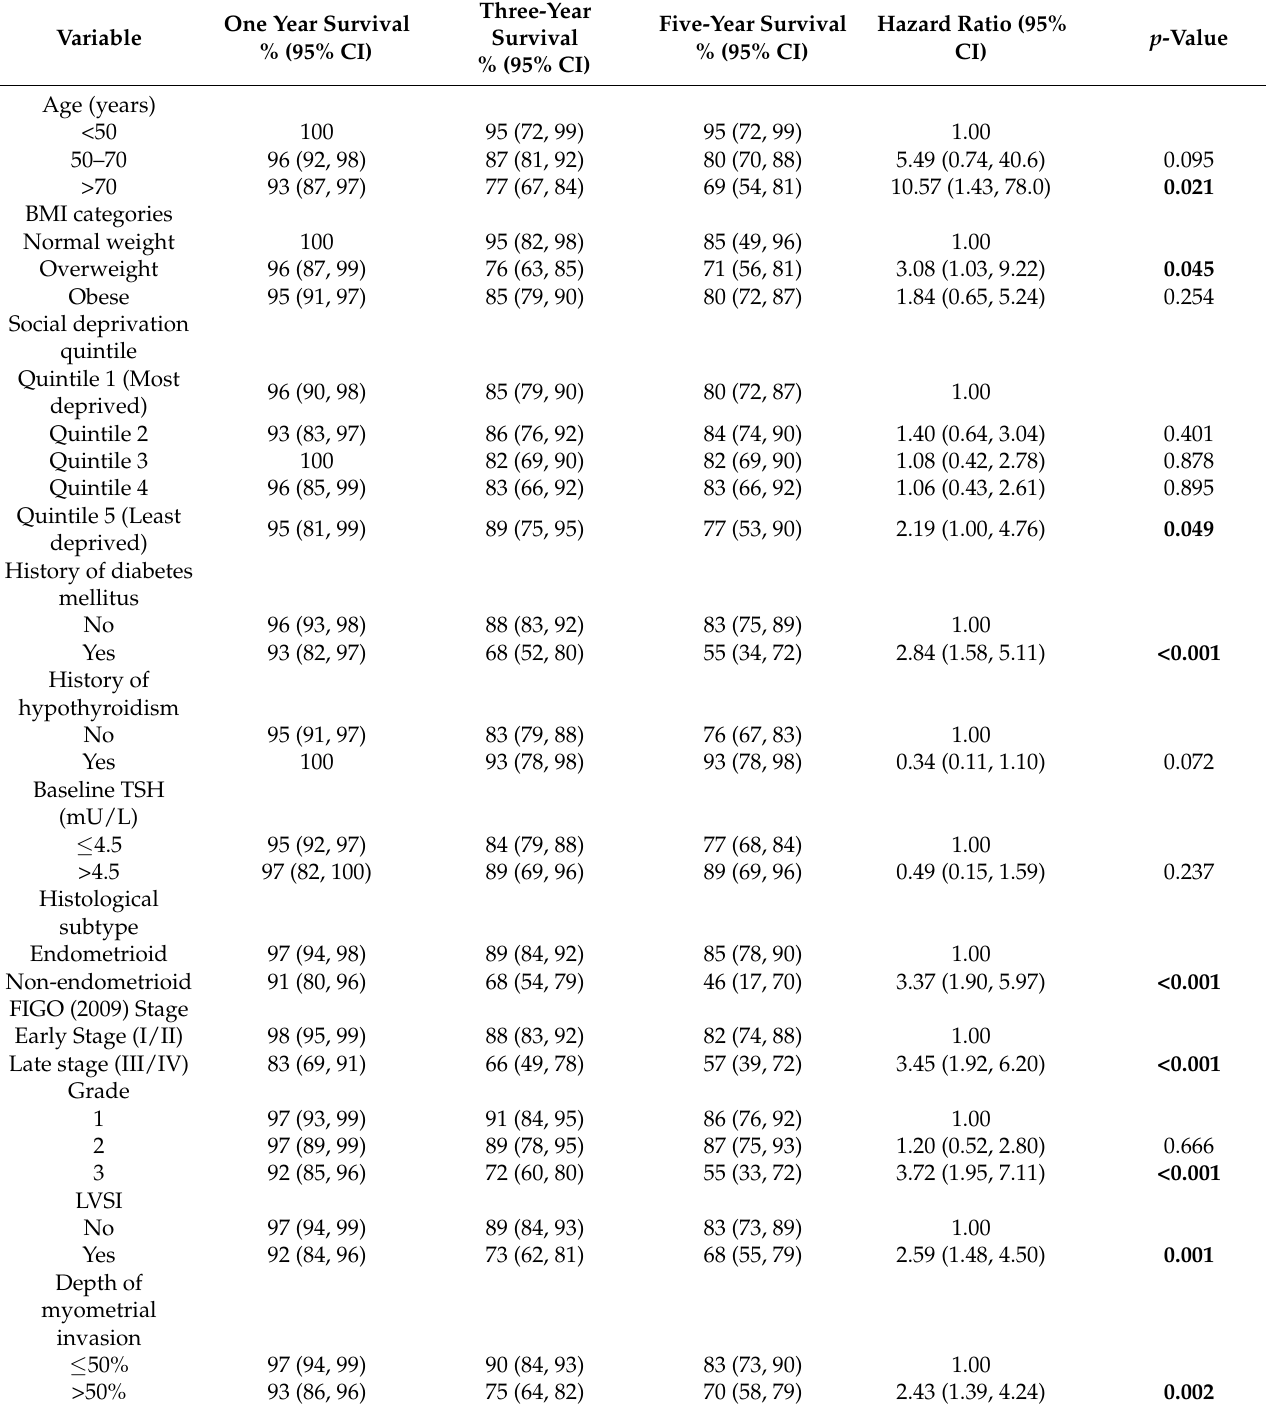
Table 3. One-, three-, and five-year overall survival rates and unadjusted hazard ratios with 95% confidence intervals by demographic and clinical predictor